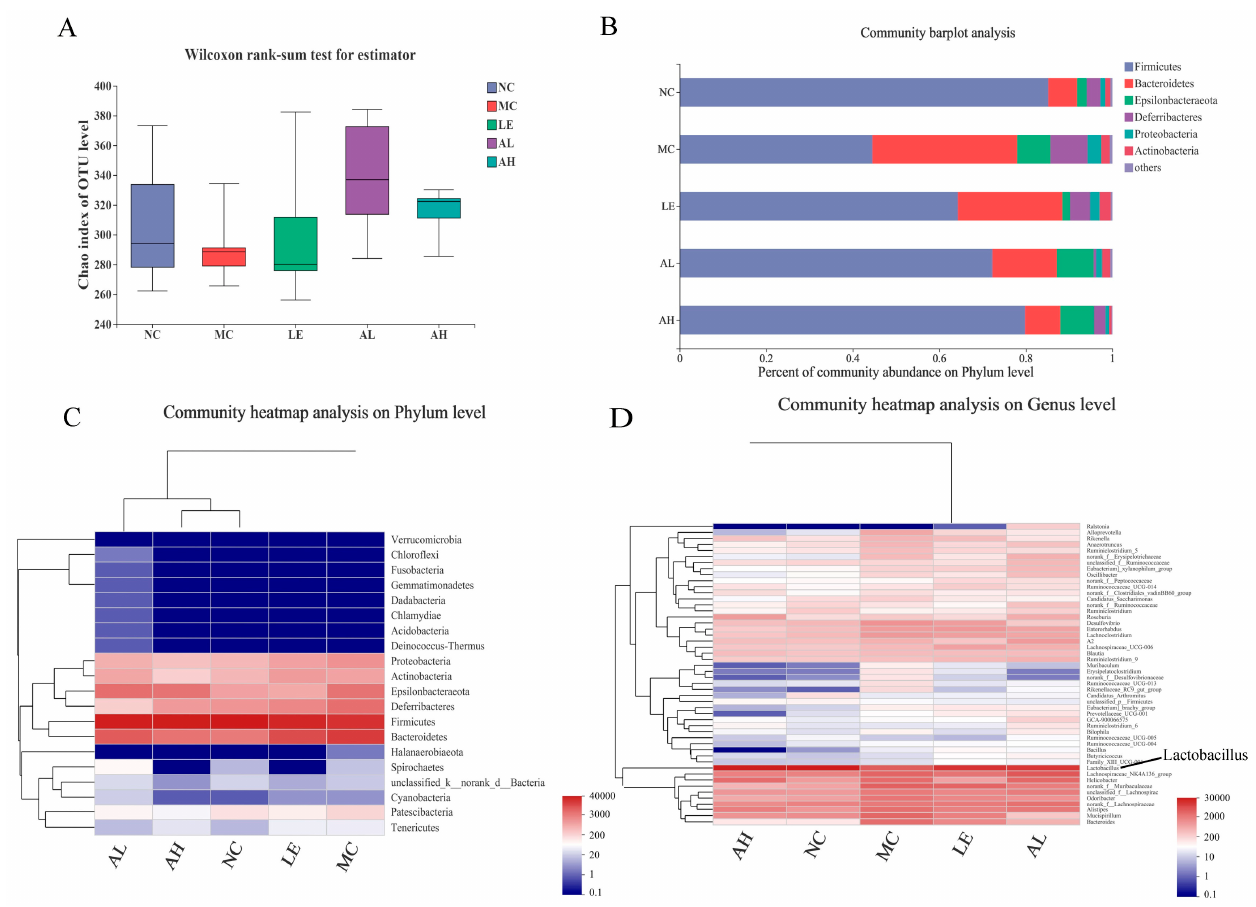
Figure 6. Microbial Alpha diversity and composition analysis of mice treated with different diets. ( A ) Alpha diversity analysis of Chao index of OTU level. ( B ) Relative abundance on the phylum level in barplot analysis. ( C ) Species abundance clustering heatmap on phylum level, the closer distance and the shorter branch length between the two samples suggest that the species composition and abundance of the two samples is more similar; the color gradient from blue to red indicates the relative abundance from low to high. ( D ) Species abundance clustering heatmap on genus level. LE, 300 mg/kg.bw/d Lentinan; AL, 300 mg/kg.bw/d AAPS; AH, 600mg/kg.bw/d